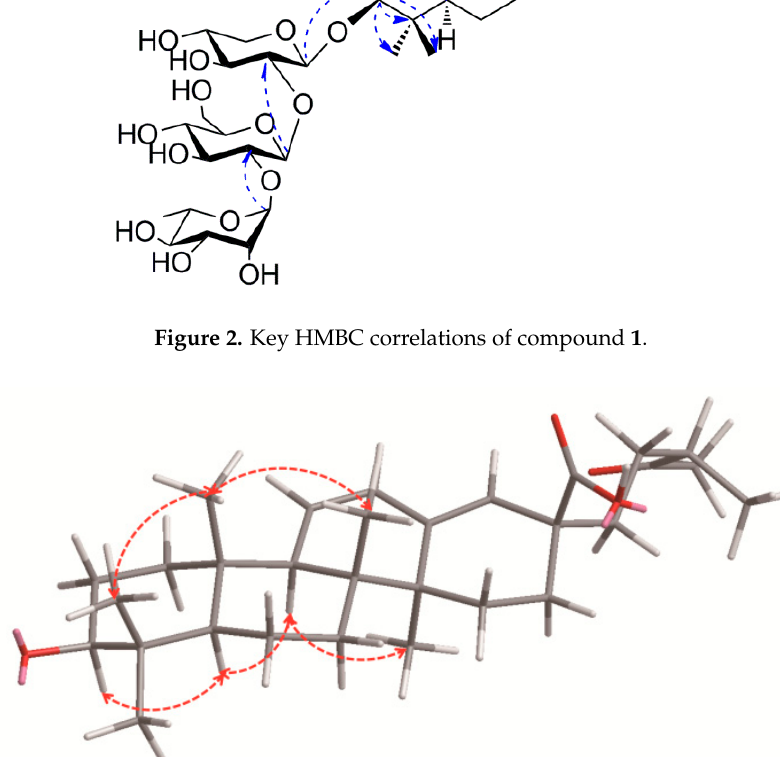
Figure 3. Key ROESY correlations of compound 1 .